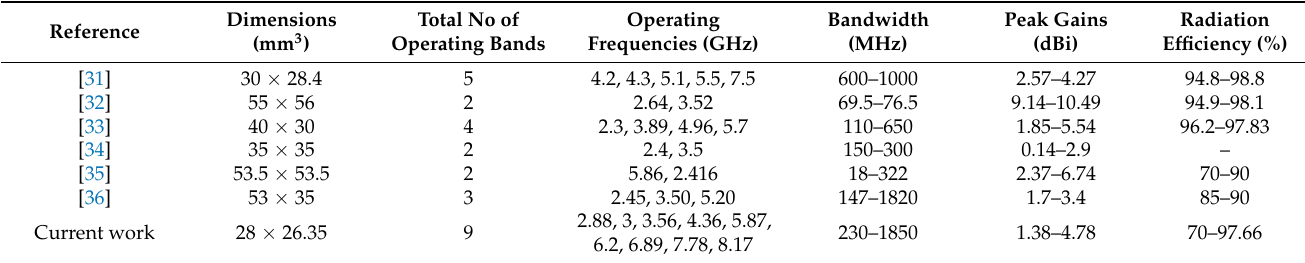
Table 4. The comparison between our antenna and other